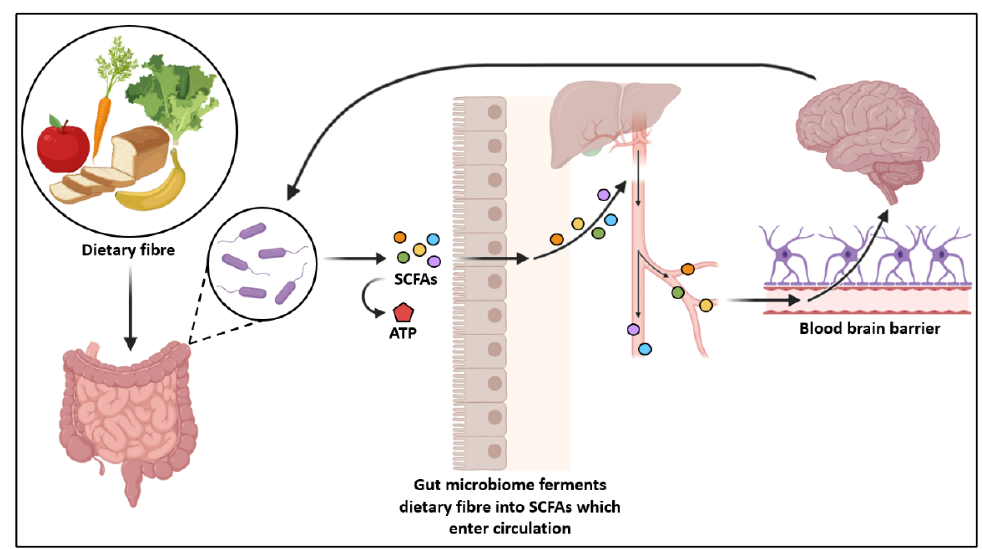
Figure 2. The gut-brain-axis showing the bidirectional relationship between the gut microbiome and the nervous system. The gut microorganisms ferment dietary fibre which produces SCFAs. The SCFAs are proposed to enter the circulatory system and into the brain via the blood brain barrier.